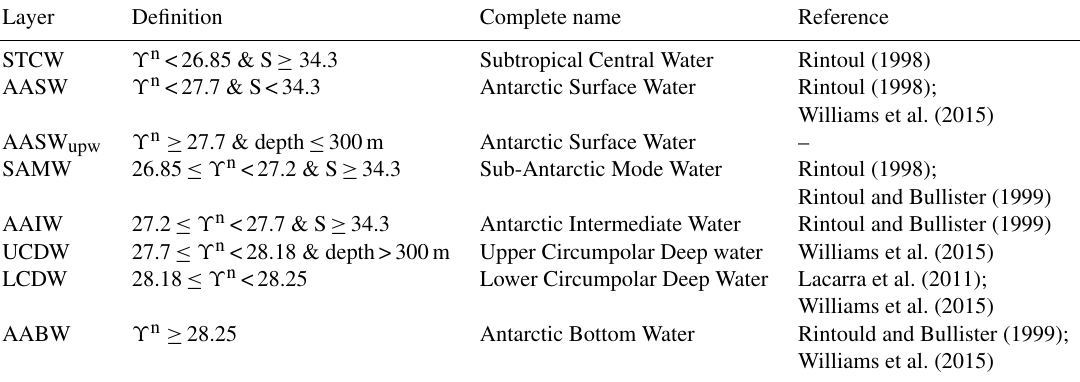
Table 2. Definition of the water mass layers between neutral surfaces ( γ n ) and references used to accordingly decide the limits of the layers. We also consider limits in salinity, depth and position of the ACC fronts (see Table 3) to differentiate better some of the